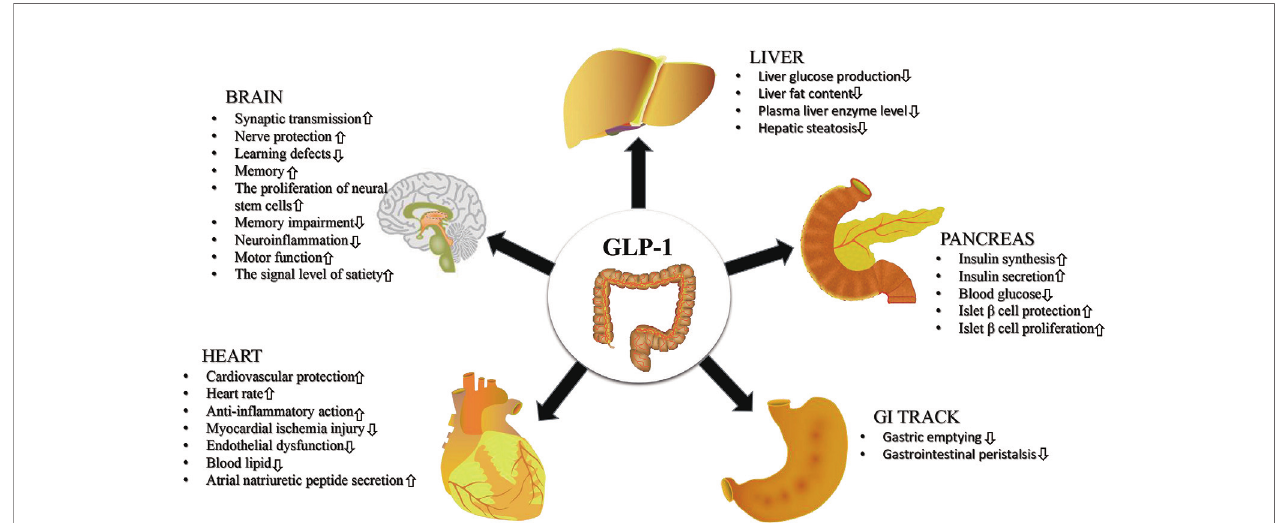
FIGURE 1 | The effects of GLP-1RAs on multiple human organizations. GLP-1RAs exert a positive therapeutic effect on human brain, pancreas, heart, gastrointestinal tract (GI tract) and